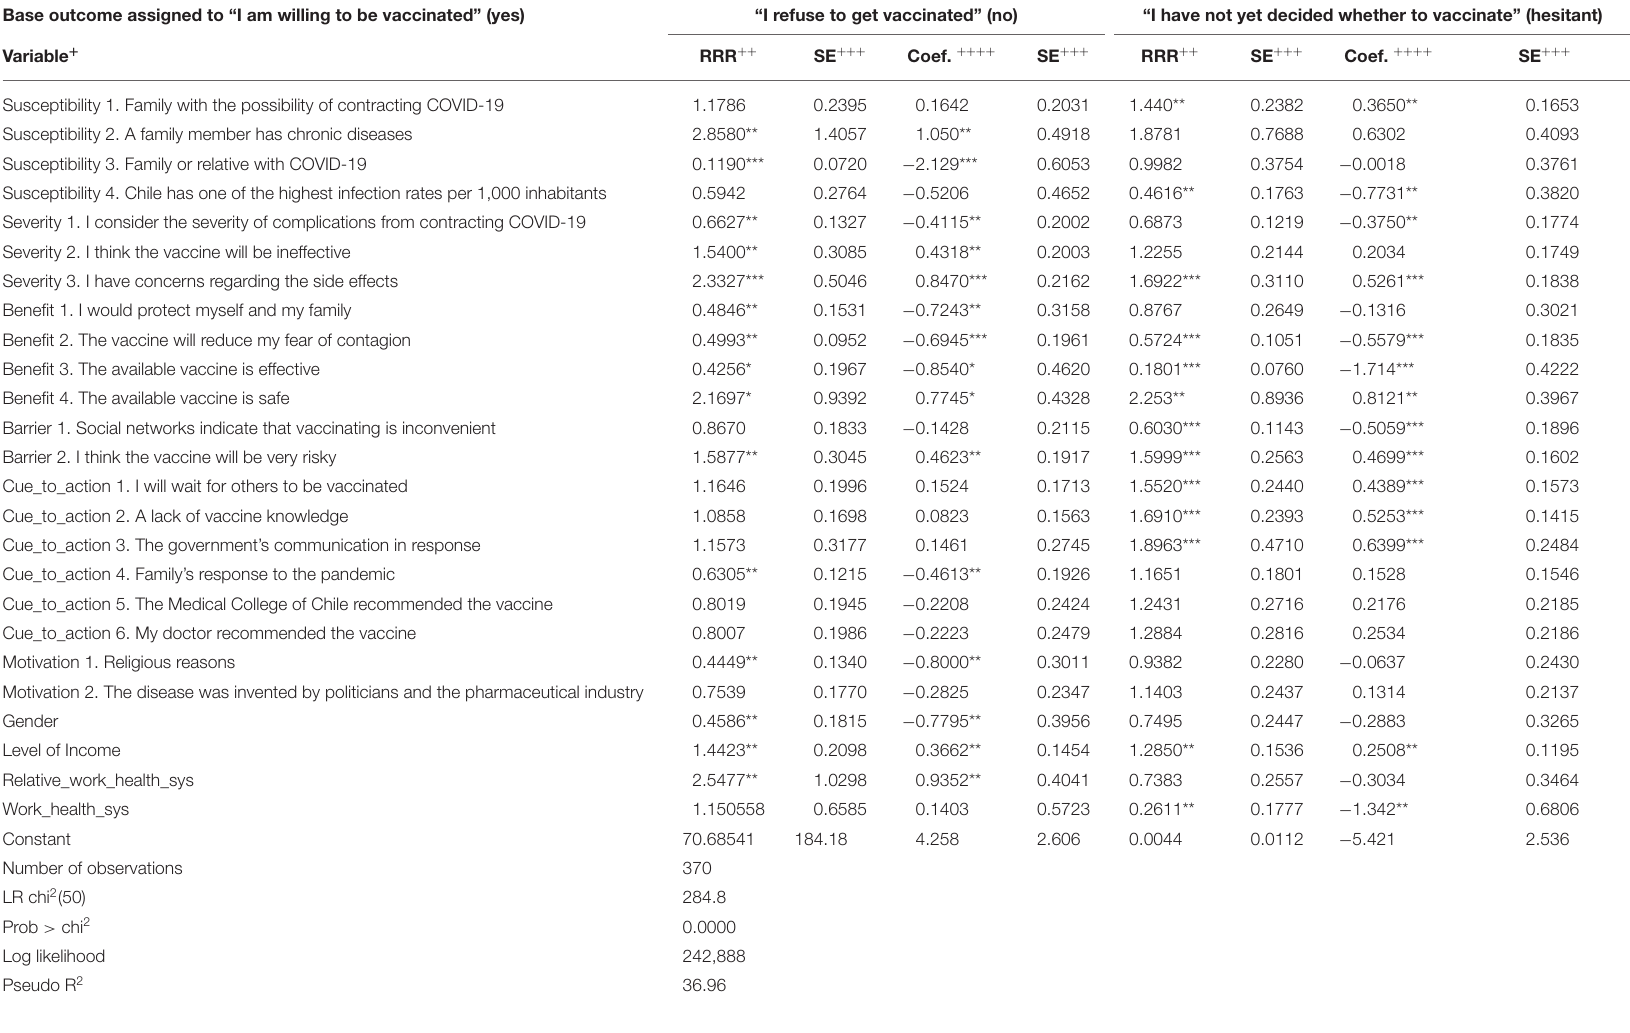
TABLE 4 | Multinomial logit estimations based on the Health Belief Model to get vaccination. Base outcome assigned to “I am willing to be vaccinated”